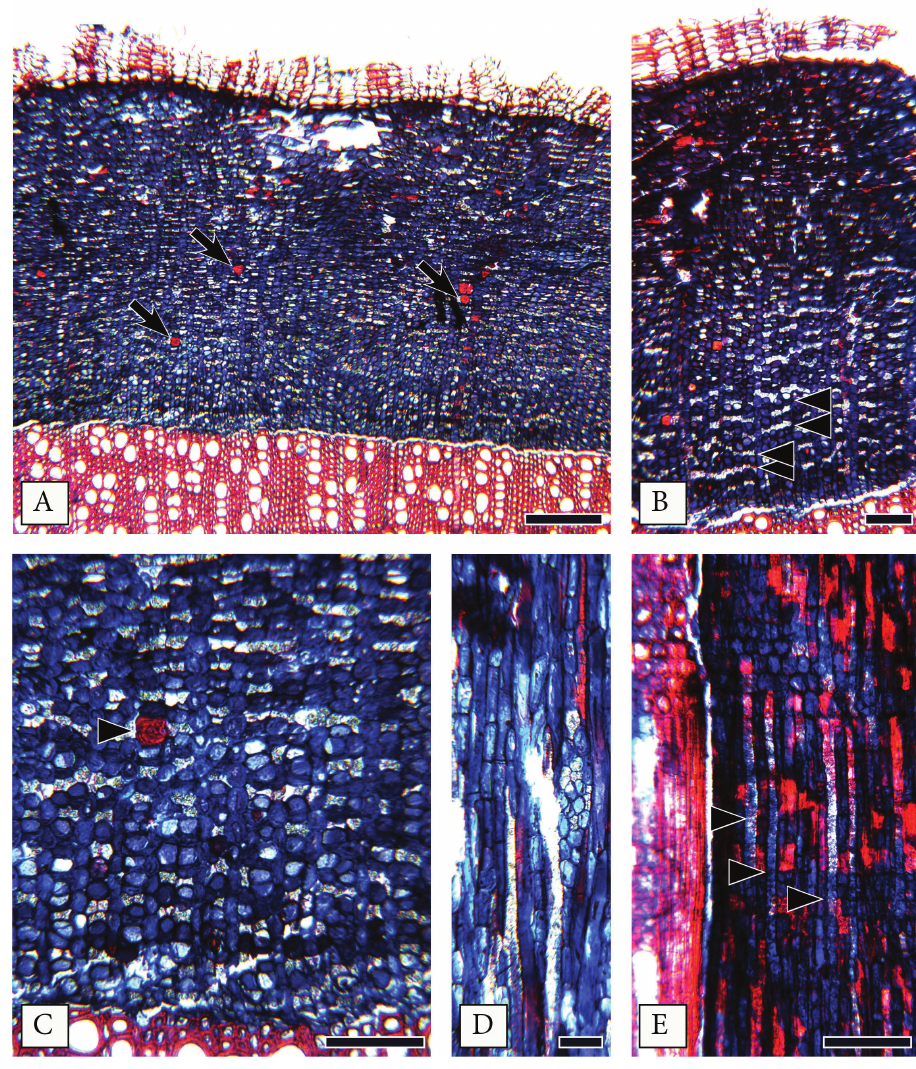
Figure 2. Secondary phloem of Mcvaughia sergipana . A–C Transverse section: A Phloem non-stratified, with scattered fiber-sclereids (arrows); Rays dilating slightly B Crystalliferous axial parenchyma arranged in diffuse-in-aggregate narrow bands (arrowhead) C Crystalliferous axial parenchyma with druse crystals, forming diffuse in aggregate bands, isolated fiber-sclereids present (arrowhead) D A ray 3 cells wide, fiber- sclereids and axial parenchyma in tangential section E Bands of crystalliferous parenchyma with druses evident also in radial section; Rays heterocellular mixed. Scale bars: 200 μm ( A ), 100 μm ( B–C, E ), 50 μm ( D ).